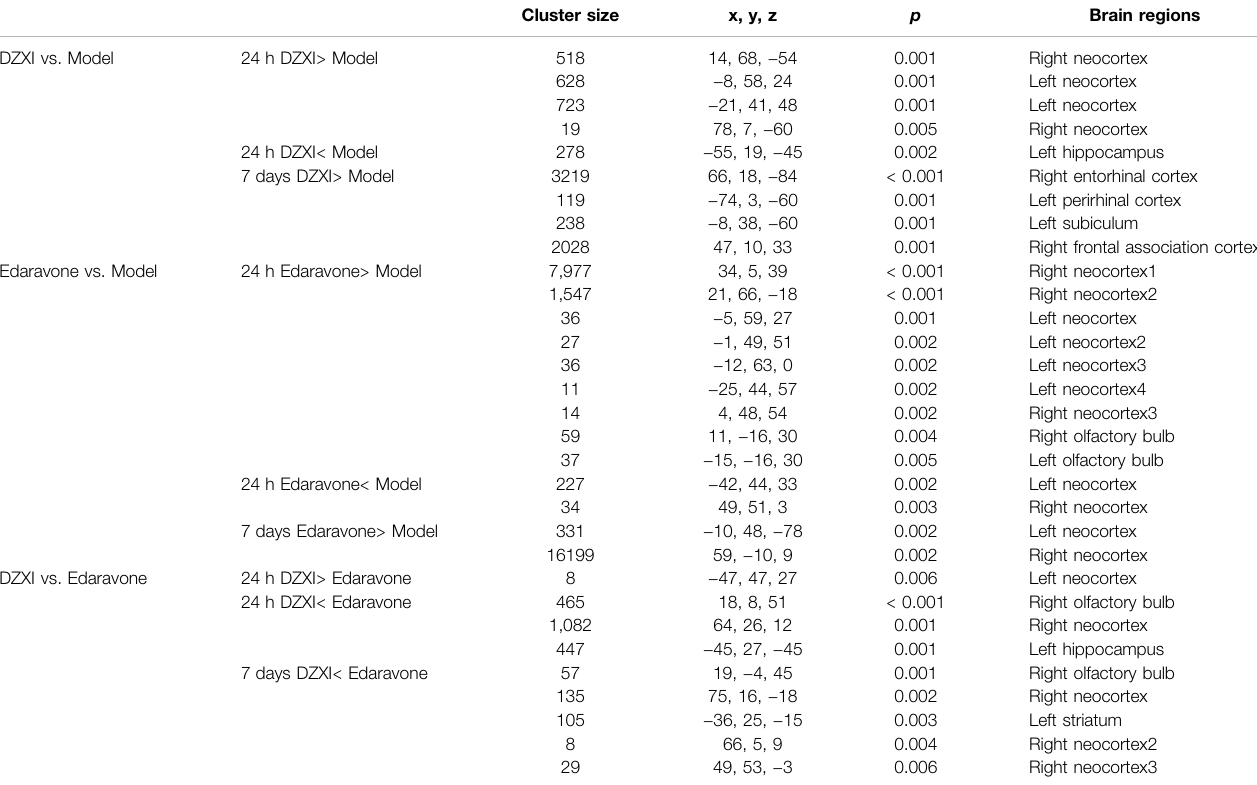
TABLE 3 | The grey matter regions displaying signi fi cant volume differences between groups in rats at 24th h and 7th day of treatments. Cluster